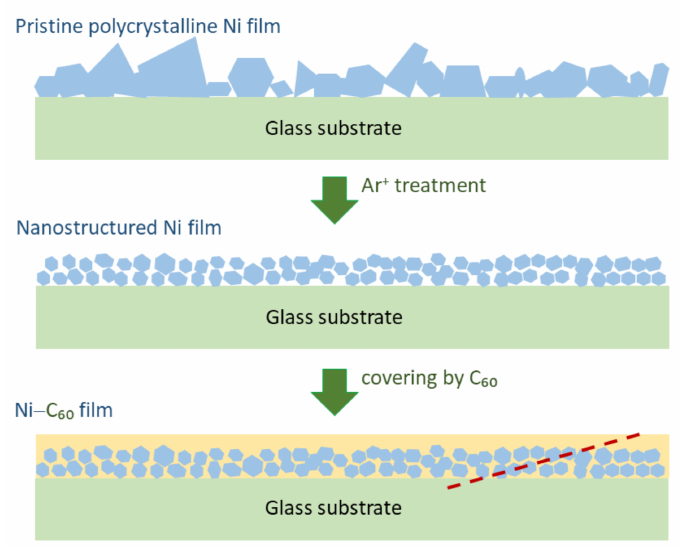
Figure 1. Schematics of the as-grown ( top image), Ar + –treated ( middle image) Ni film and Ni- C 60 composite layer ( bottom image). Dashed line in the bottom image schematically illustrate the side edge of the Ar + ion etching crater used to obtain scanning electron microscopy (SEM) imagesgiven